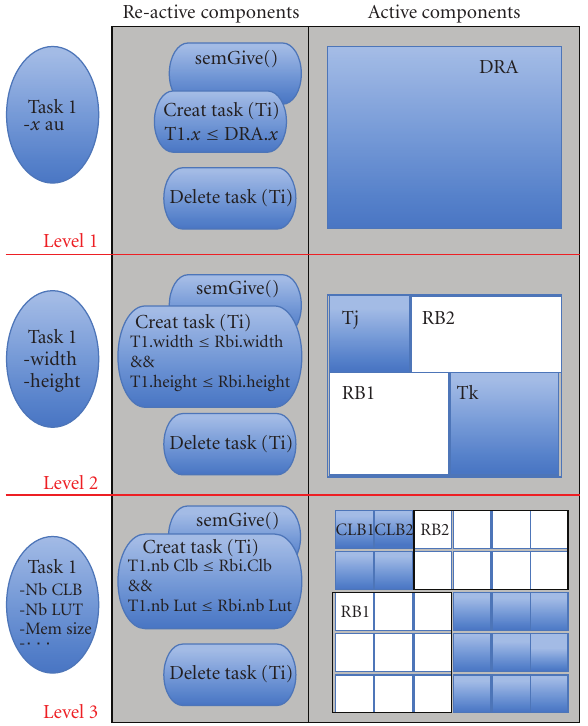
Figure 10: Hierarchical model of the active and reactive compo- nents of the DRA. The di ff erent levels permit to represents the DRA with more or less details. Refinement process leads to the complete definition of the internal architecture of the DRA. Belonging to the refinement of architectural aspects ( active component), the supported services can be developed and evaluated ( reactive